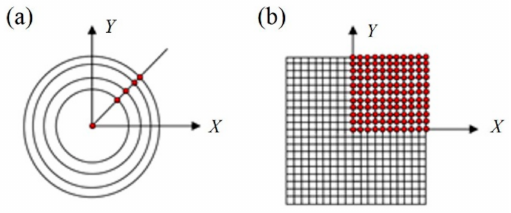
Figure 3. Sampling points diagram. ( a ) Rotating axis-symmetric system and ( b ) XYP orthogonal